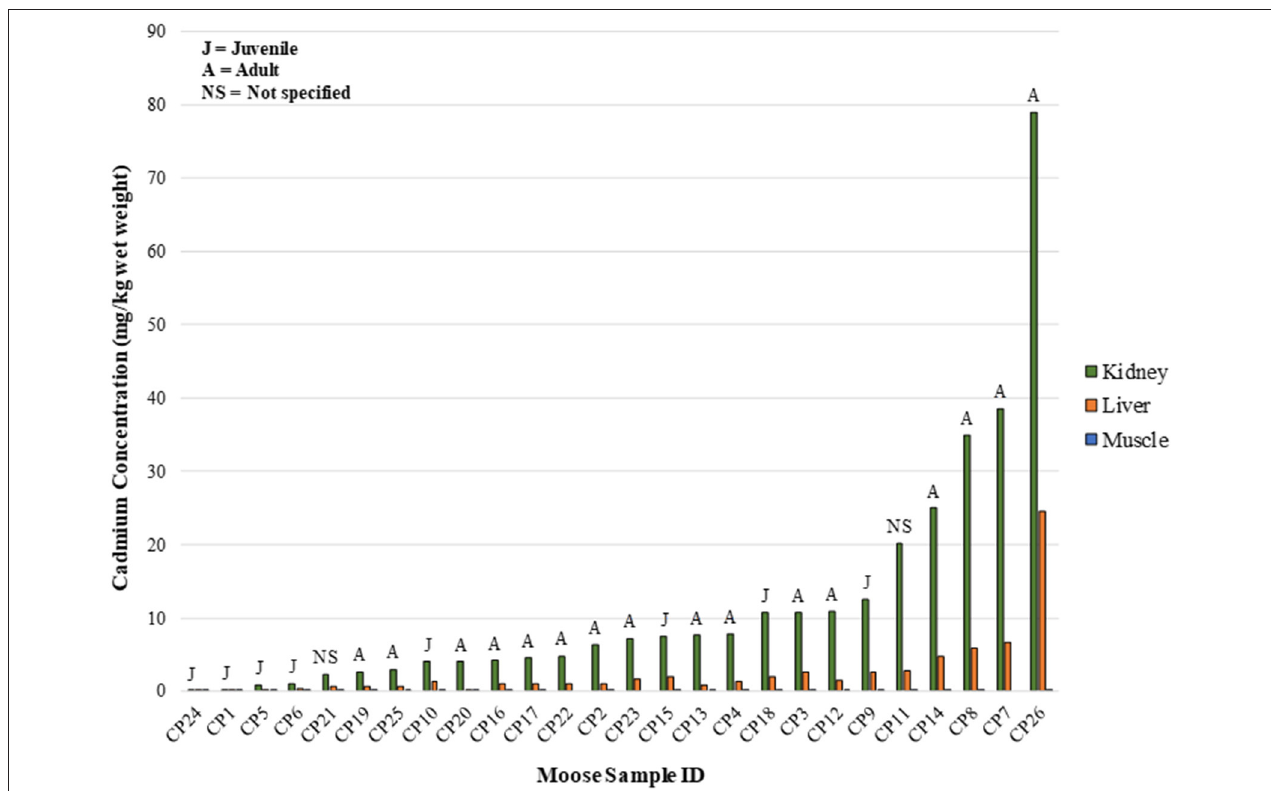
FIGURE 3 | Moose tissue concentrations -